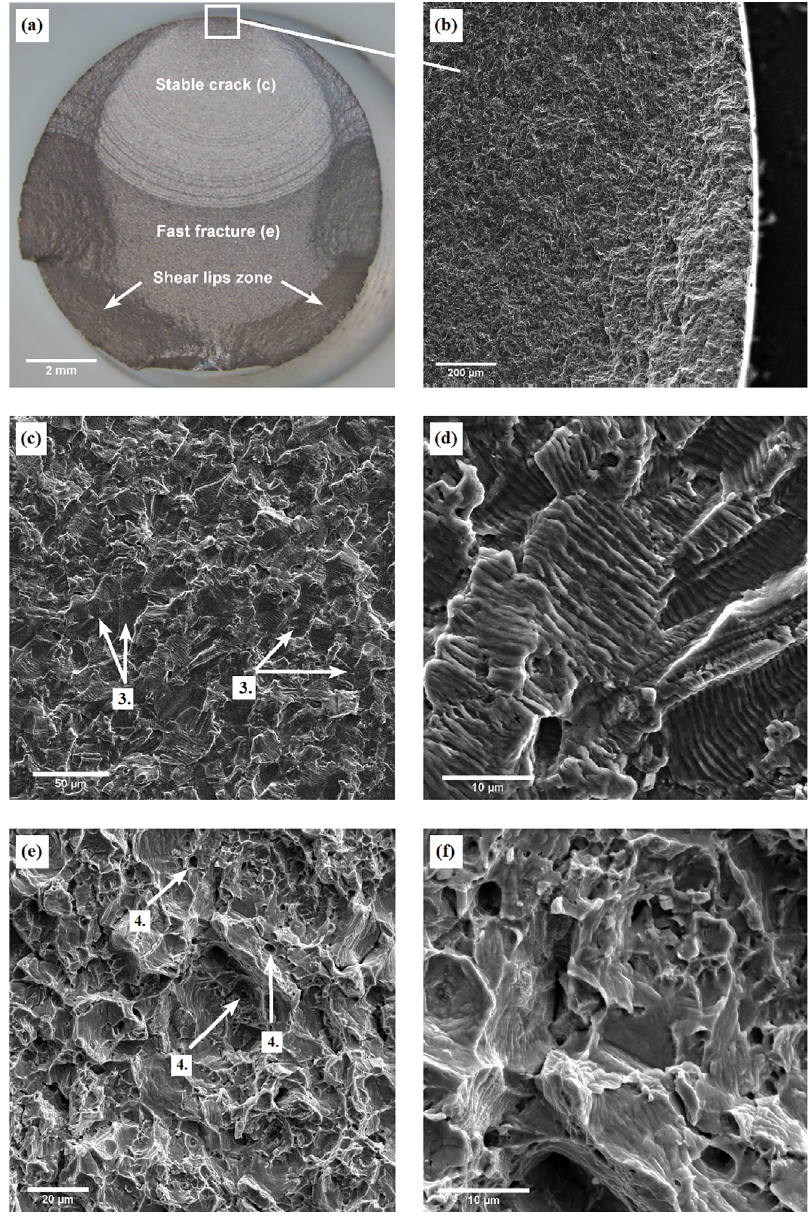
Figure 12 . Inconel 625 fracture surface after failure at 164814 cycles under maximum stress of 382 MPa: (a) appearance of the fracture surface, (b) microscopic crack nucleation region, (c) failure mode in the stable crack growth region, (d) fatigue striations, (e) failure mode in the fast fracture region, (f)